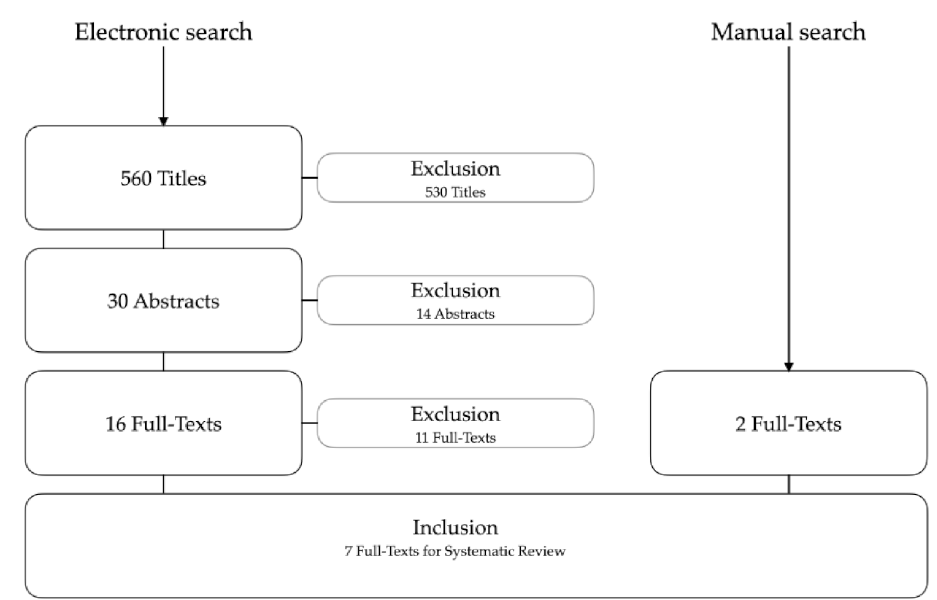
Figure 1. Flowchart of the electronic and manual search